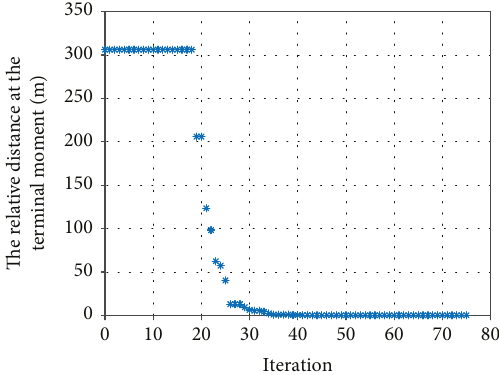
Figure 4: Convergence process of the relative distance at the terminal